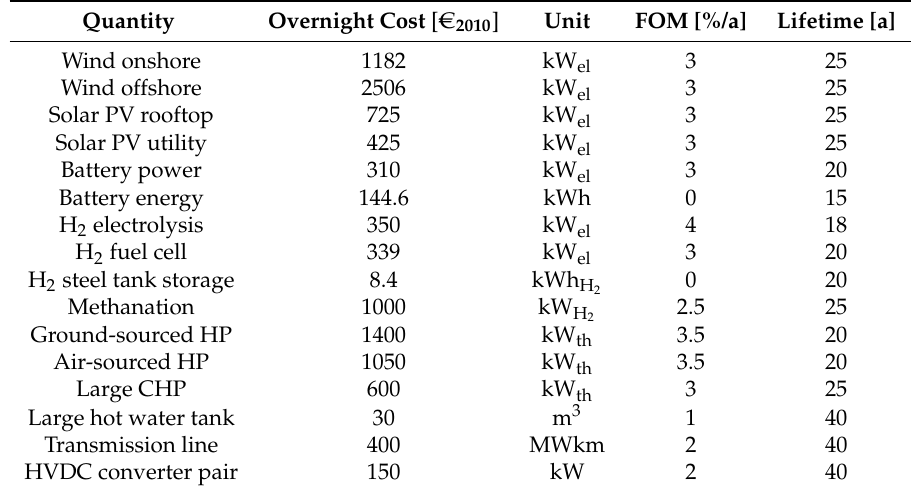
Table 1. Technology assumptions projected for 2030 (FOM is Fixed Operation and Maintenance costs, given as a percentage of the overnight